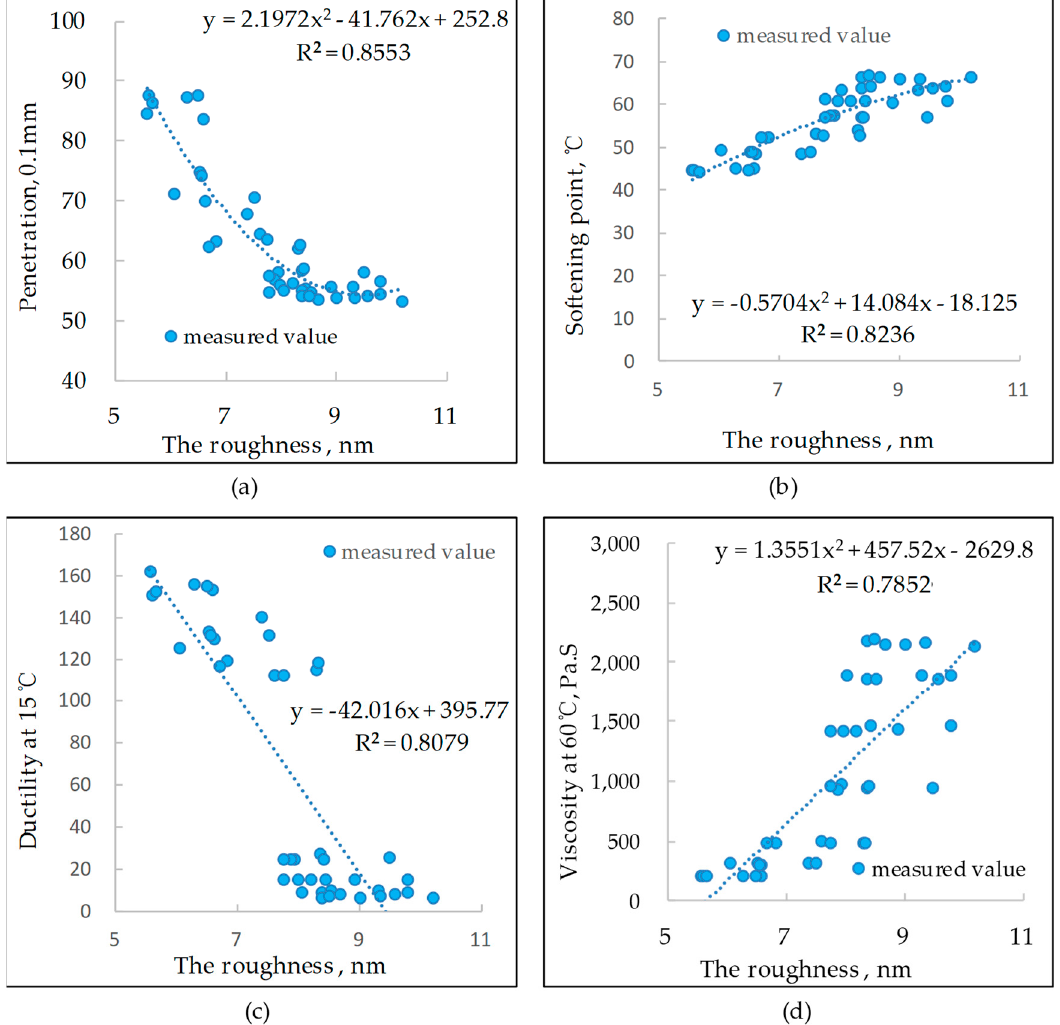
Figure 12. The relationships between the roughness and technical indexes. ( a ) penetration at 25 °C; ( b ) softening point; ( c ) ductility at 15 °C; ( d ) viscosity at 60 °C.